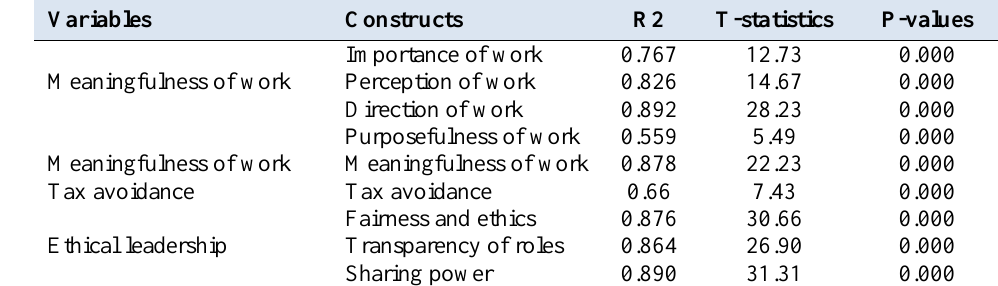
Table 5. Coefficient of determination (R2)